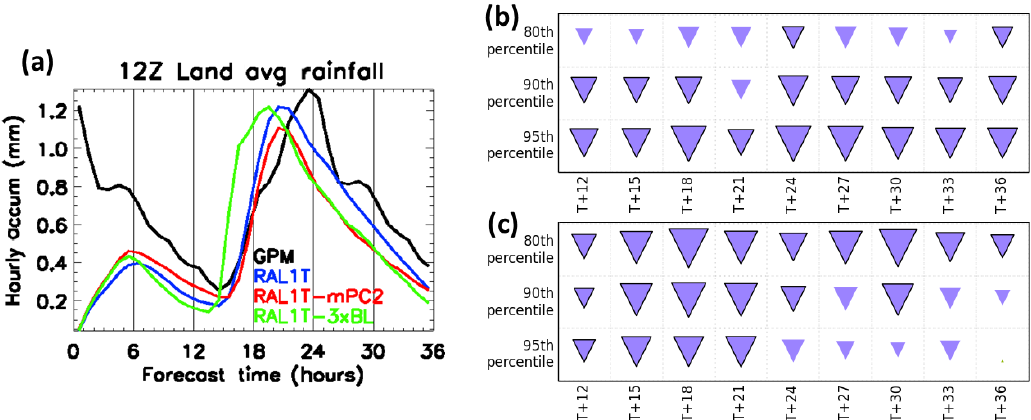
Figure 14. (a) Domain-averaged rainfall time series for all forecasts initialised at 12:00Z for November 2016. (b) Hinton plot showing the difference in FSS due to removing ticket 16 (RAL1-T-mPC2 minus RAL1-T) for a 250km length scale compared to 3-hourly GPM. Panel (c) is as panel (b) , but showing the impact on FSS of reverting the three BL changes back to the RAL1-M settings (RAL1-T-3xBL minus RAL1-T). Note that on the Hinton plots downward-pointing purple triangles indicate that RAL1-T is more skilful, whilst solid lines around the triangles denote that the difference is statistically significant.